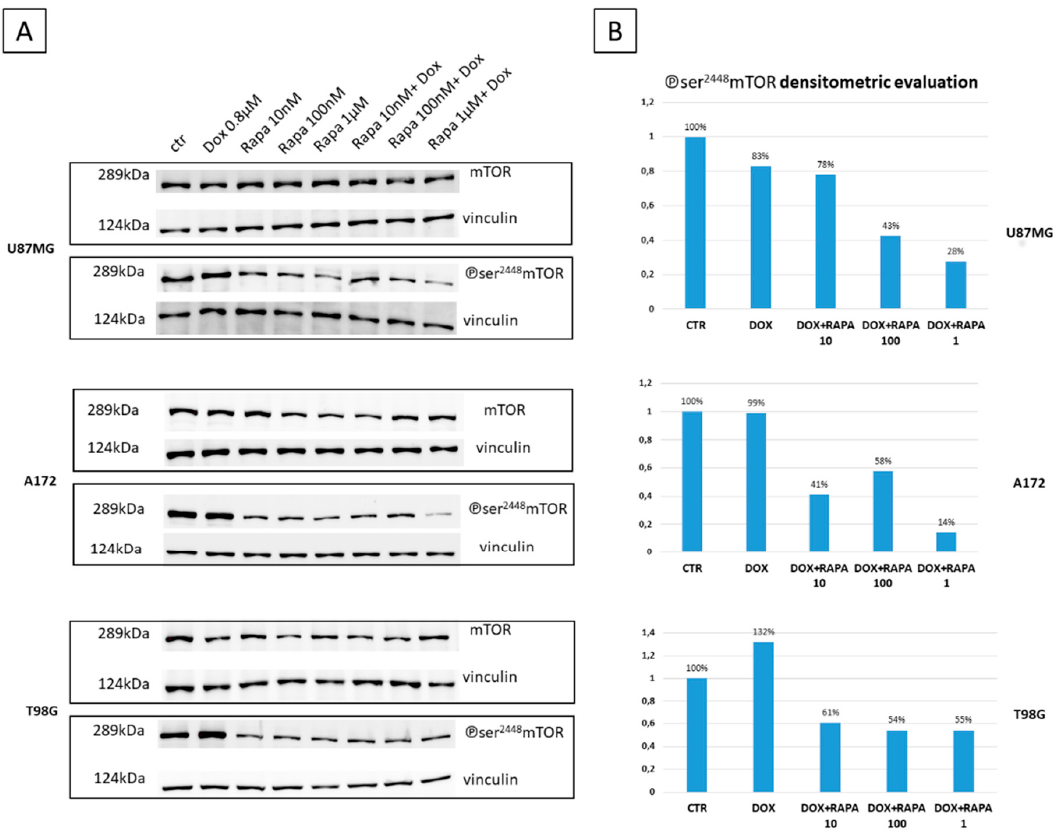
Figure 3. Effect of Rapa on mTOR S2448 phosphorylation ( A ) Immunoblot analysis of mTOR and ℗ ser 2448 mTOR signaling in U87MG, A172, and T98G glioma cells, treated with Dox, various concentrations of Rapa and their combinations for 8 h. Vinculin was used as a protein loading control; ( B ) Densitometric analysis of ℗ ser 2448 mTOR signaling in U87MG, A172, and T98G glioma cells. All samples were normalized vs. vinculin and ℗ ser 2448 mTOR levels were referred to CTR (100%).